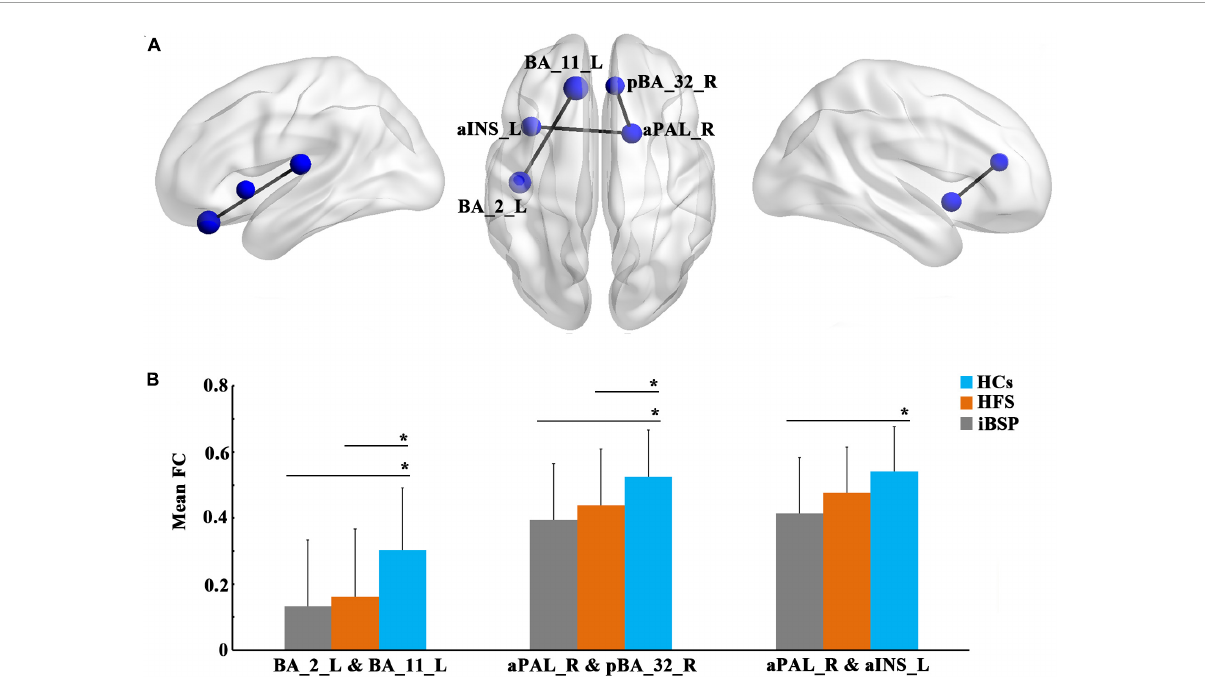
FIGURE3 Decreased functional connections at the regional level. (A) Significantly decreased functional connections at the regional level in patients with idiopathic blepharospasm compared with healthy controls (HCs). The results were corrected by Bonferroni corrections of P < 1.22 × 10 - 5 . (B) Differences in mean functional connectivity among the three groups. Group differences in functional connectivity were explored using analysis of covariance and post-hoc two-sample t -tests between any two groups, with age and gender as covariates. *Represents significant results with P < 0.05. Abbreviations are listed in Table 3 .